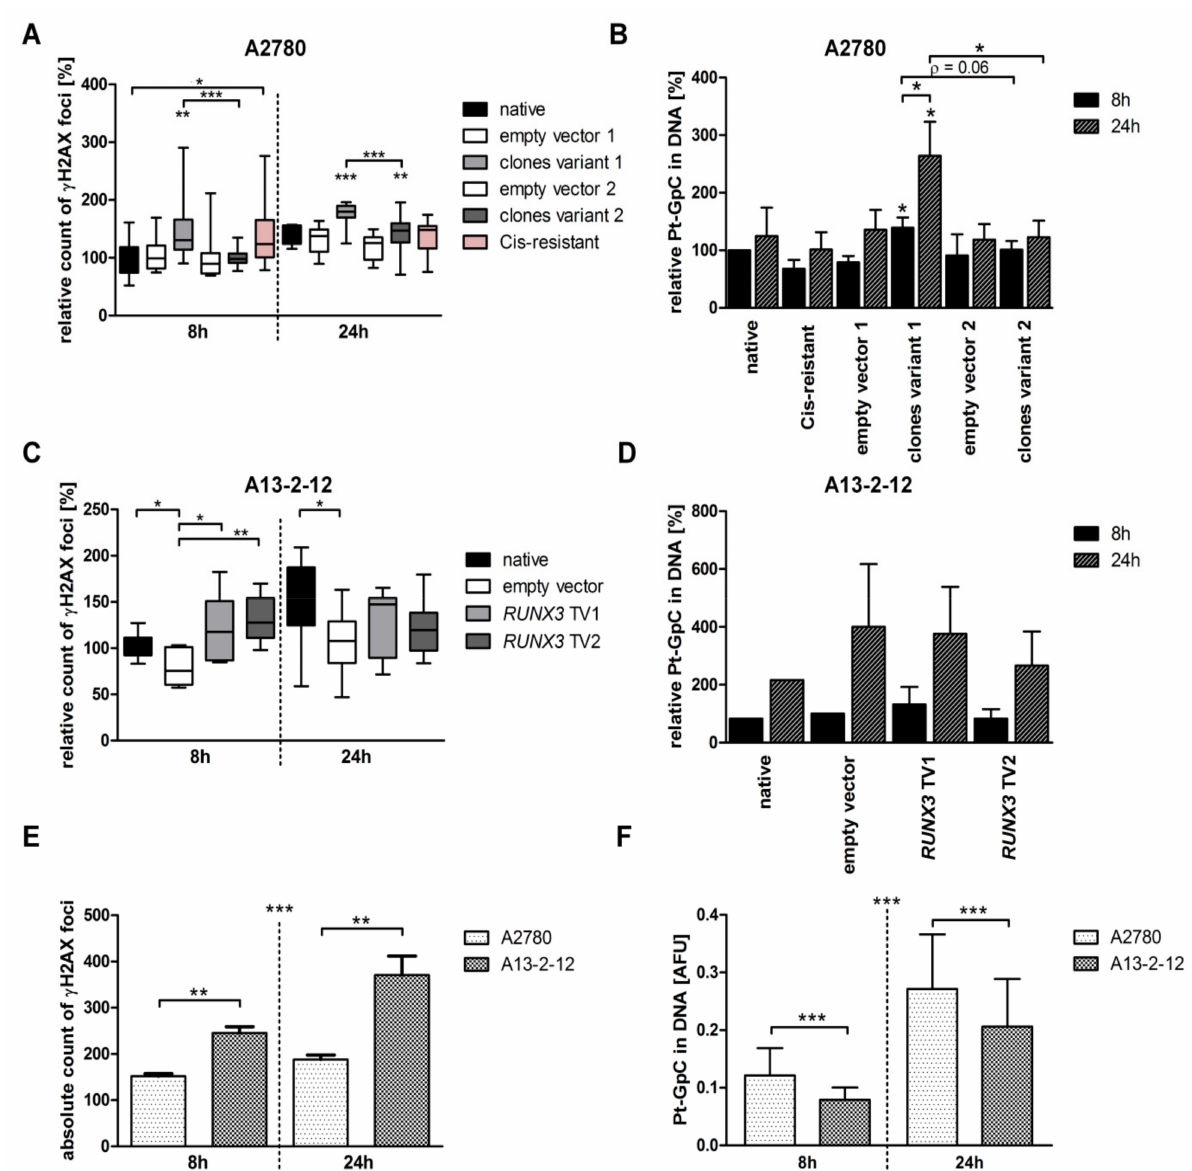
Figure 3. Measurement of cisplatin-induced DNA damage effects. ( A ) Relative γ H2AX foci signals per cell in A2780 cells. After 8 h treatment Cis-resistant and RUNX3 transcript variant 1 overexpressing cells harbored an increase in detected signals compared to parental A2780 or empty vector controls. A significantly higher number of foci were also detected in TV1- compared to TV2-expressing cells. After 24 h, higher numbers of γ H2AX foci was also seen in TV2 expressing A2780 cells compared to empty vector cells. However, cells expressing TV1 had still higher DNA damage than TV2 cells at 24 h. n ≥ 2, total analyzed cells ≥ 1600. ( B ) Relative level of platinum-DNA-adducts in A2780 cells. Enrichment of the adducts was detected in cells overexpressing RUNX3 transcript variant 1 in a time-dependent manner. The level of platinum-DNA-adducts differed between cells expressing variant 1 and variant 2, respectively. n = 2 ( C ) In A13-2-12 cells, the overexpression of RUNX3 led in both cases to a higher amount of γ H2AX foci after 8 h of cisplatin treatment compared to control cells. This difference disappeared after 24 h. n = 2, total analyzed cells ≥ 650. ( D ) A tendency to enrich platinum-DNA-adducts upon longer treatment was seen. No changes showed a statistical significance. n = 2. ( E ) Comparing native A2780 and native A13-2-12 cells, A13-2-12 cells showed a higher level of absolute γ H2AX foci counts, which further increased over time. ( F ) On the other hand, A2780 cells experienced a stronger accumulation of platinum-DNA-adducts upon cisplatin treatment. * p < 0.05, ** p < 0.01, *** p < 0.001 in Student’s t